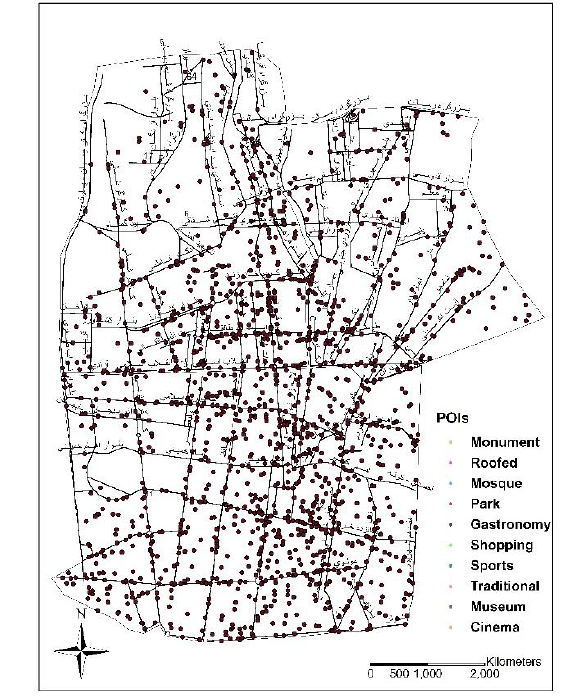
Figure 3. The dataset for the case study The proposed system uses ontology to represent features of